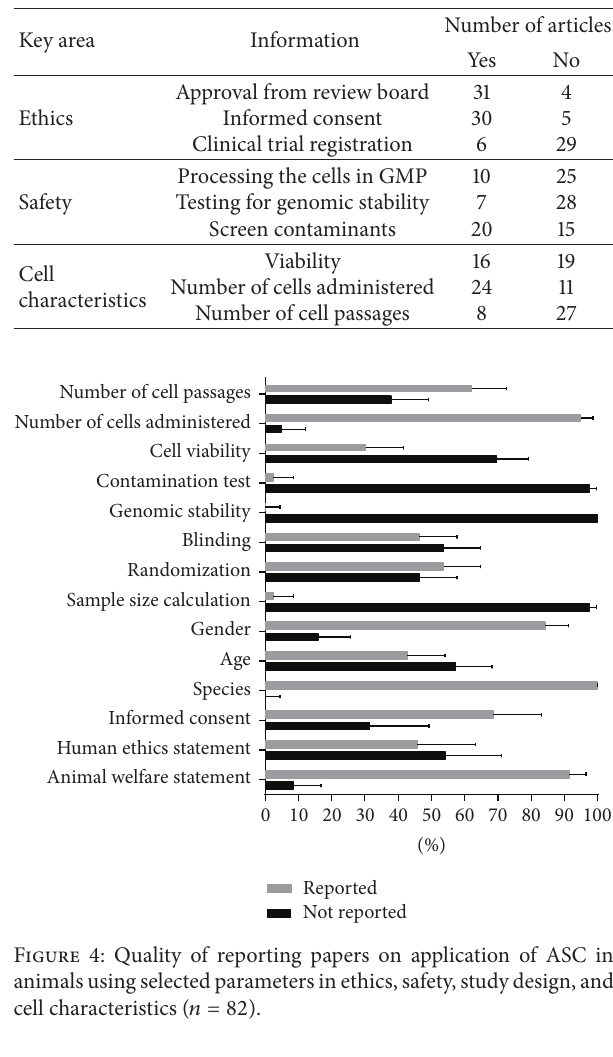
Table 5: Summary of reporting on selected key areas and parame- ters in papers that reported the use of ASC in humans ( 𝑛 = 35 ).